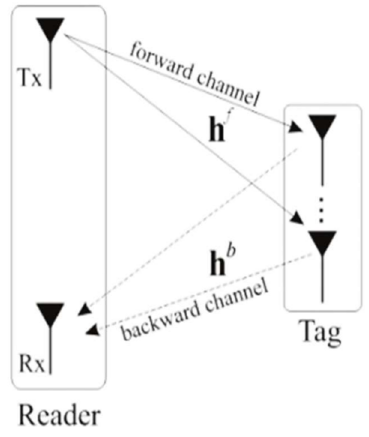
Figure 1. The backscatter system